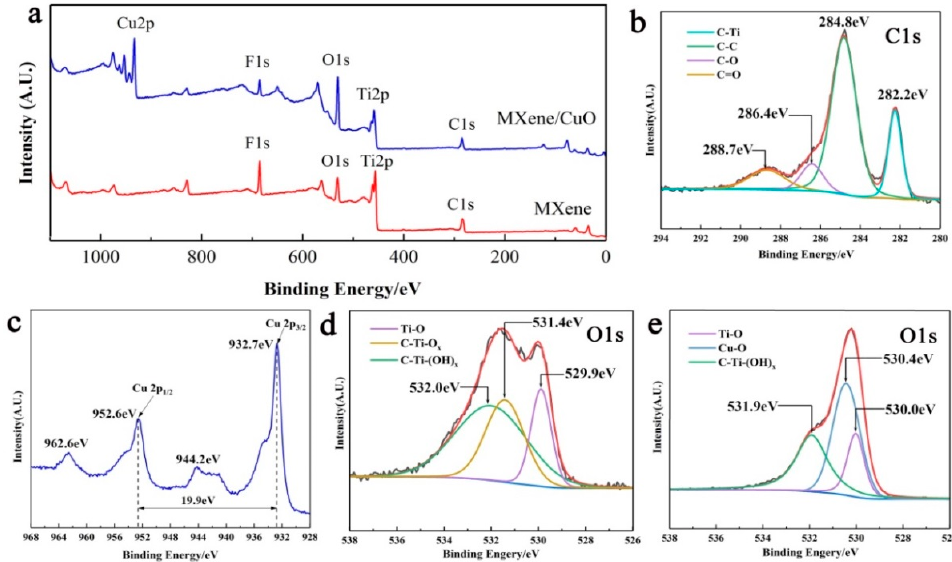
Figure 4. X-ray photoelectron spectra (XPS) of the MXene and MXene/50% CuO nanocomposite: full scan ( a ), C 1s spectra of MXene/50% CuO ( b ), Cu 2p spectra of MXene/50% CuO ( c ), O 1s spectra of MXene ( d ), and MXene/50% CuO ( e ).